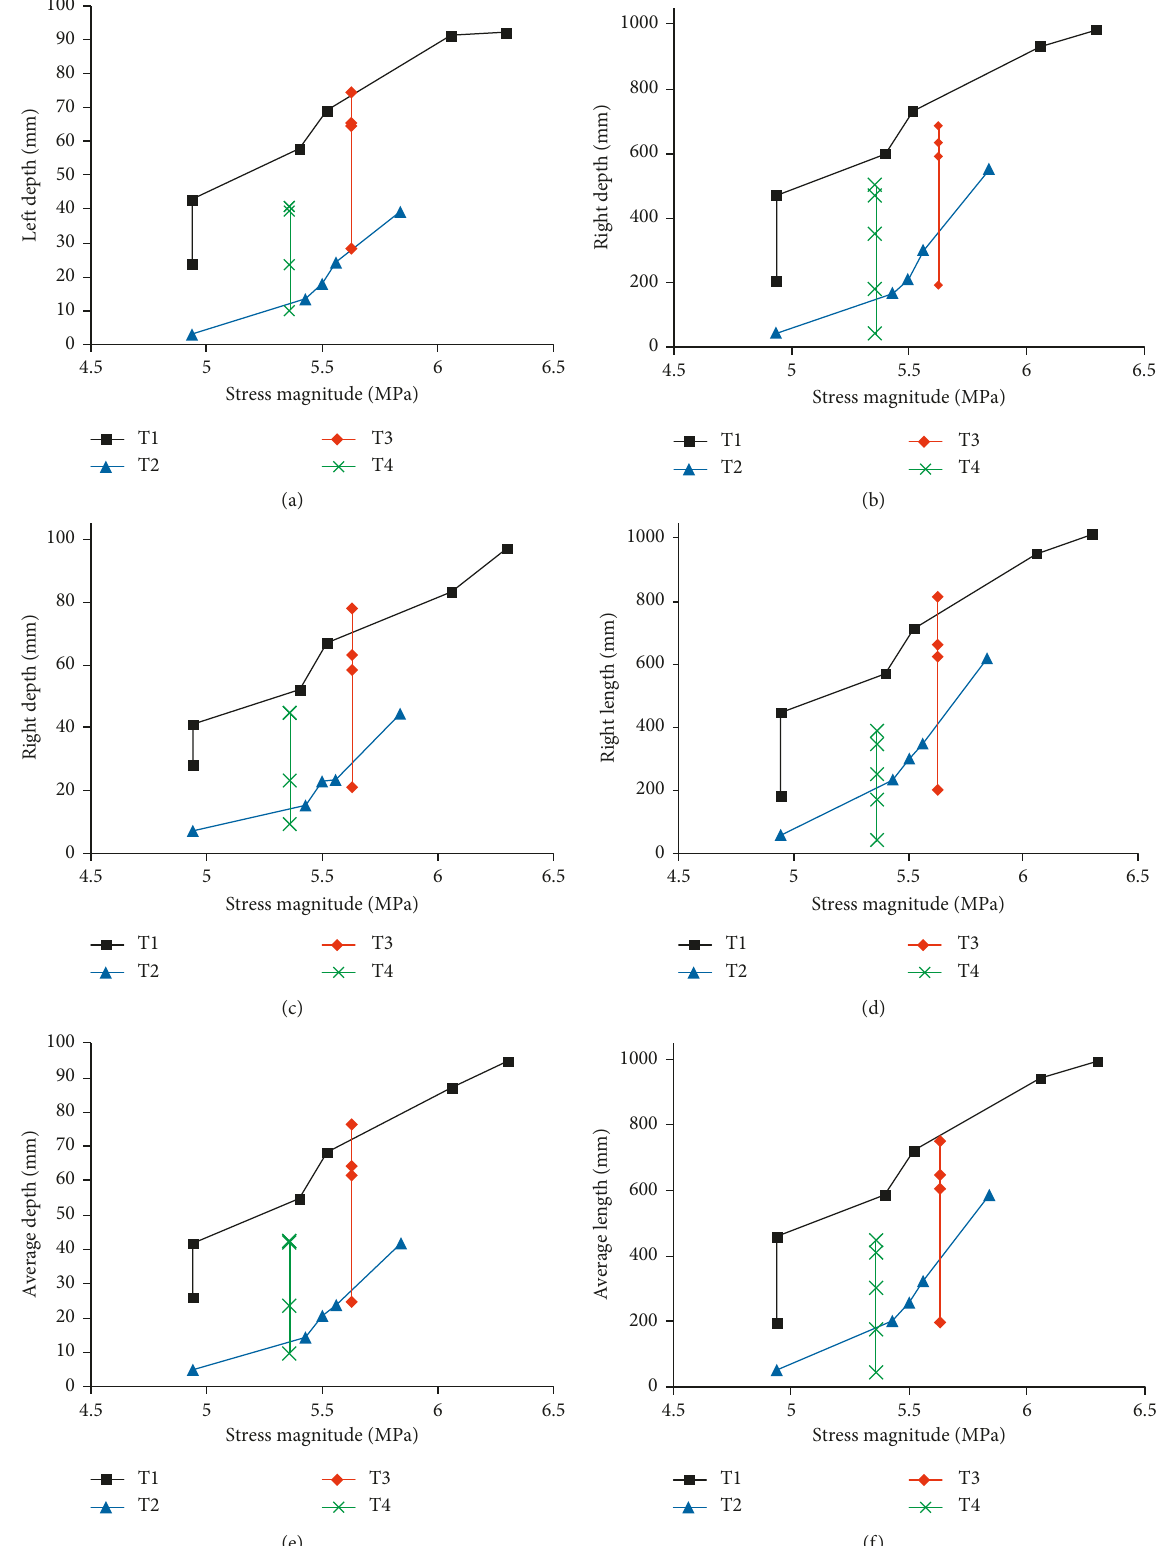
Figure 19: The length and depth of crack for three load paths. (a) Left depth. (b) Right depth. (c) Left length. (d) Right length. (e) Average depth. (f) Average